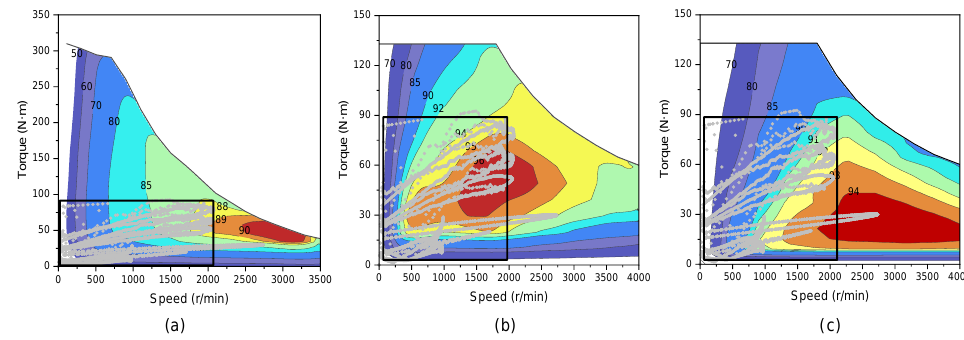
Figure 10. Three motor efficiency maps with hydraulic motor operating points. ( a ) Position of hydraulic motor operating point in SRM. ( b ) Position of hydraulic motor operating point in PMSM. ( c ) Position of hydraulic motor operating point in